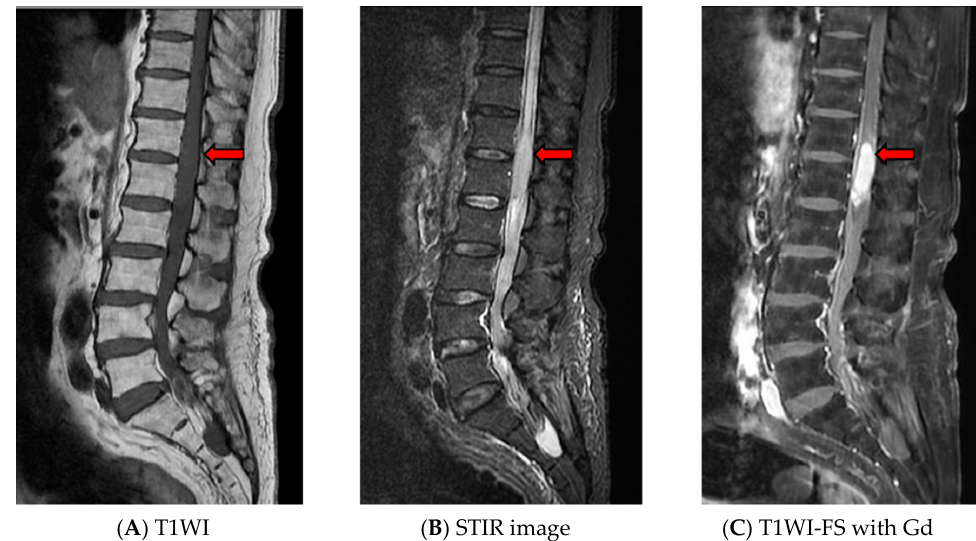
Figure 1. Magnetic resonance imaging of the lumbosacral spine revealed a 4.5 × 1.5 cm intramedullary expanding lesion at the T12-L1 level. The lesion exhibited isosignal intensity on the T1-weighted image ( A ) and hypersignal intensity on the Short tau inversion recovery (STIR) image ( B ) with homogeneous enhancement ( C ). Hypersignal intensity of the spinal cord above the lesion was also detected on the STIR image ( B ), which represented diffuse spinal cord